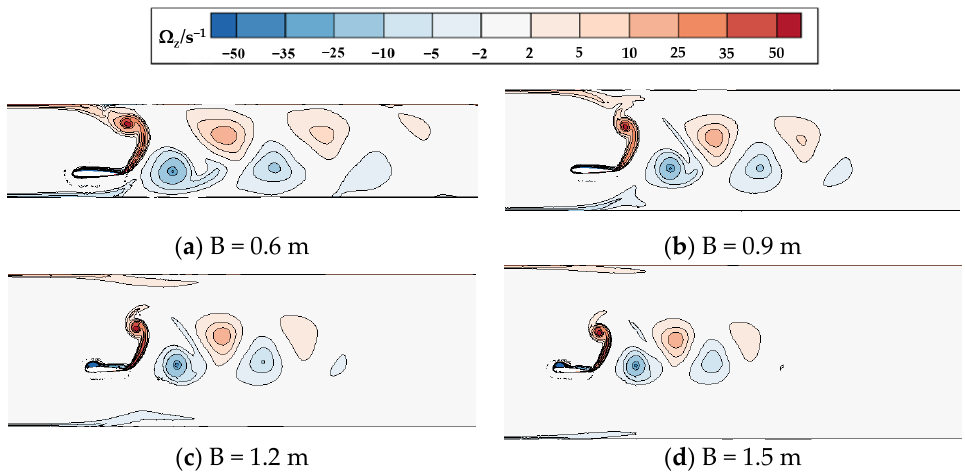
Figure 10. Velocity cloud chart of flapping hydrofoil under different passage widths.